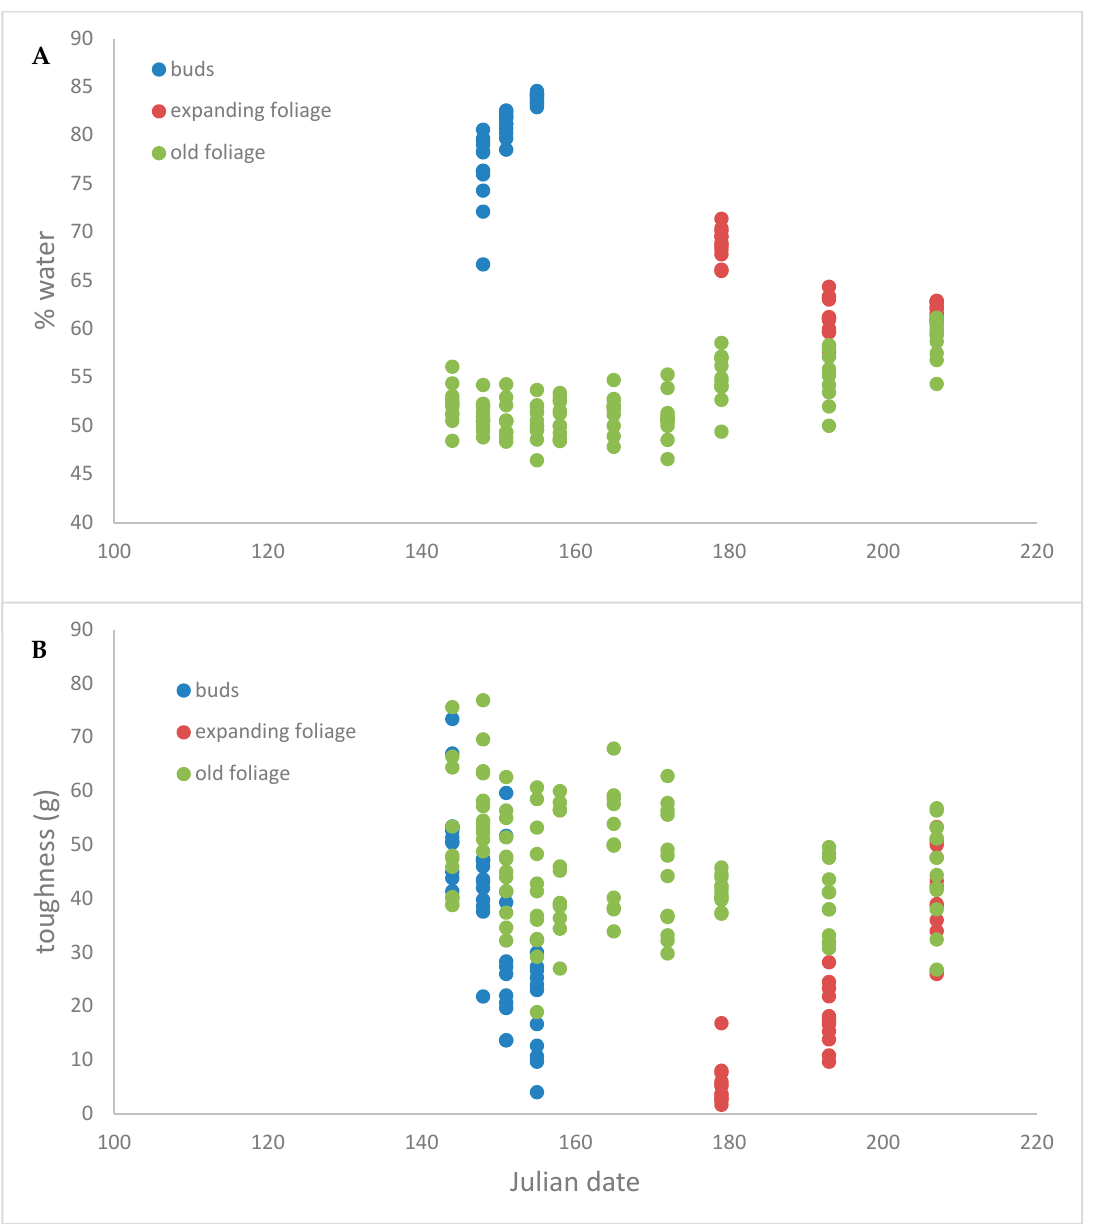
Figure 1. Time course of white spruce ( A ) water content and ( B ) leaf toughness. Green represents previous-year needles, blue represents swelling buds and red the foliage that emerges from those buds. There is a two-week gap between measurement of buds and expanding foliage in which the opening bud was too soft to permit toughness measurement.